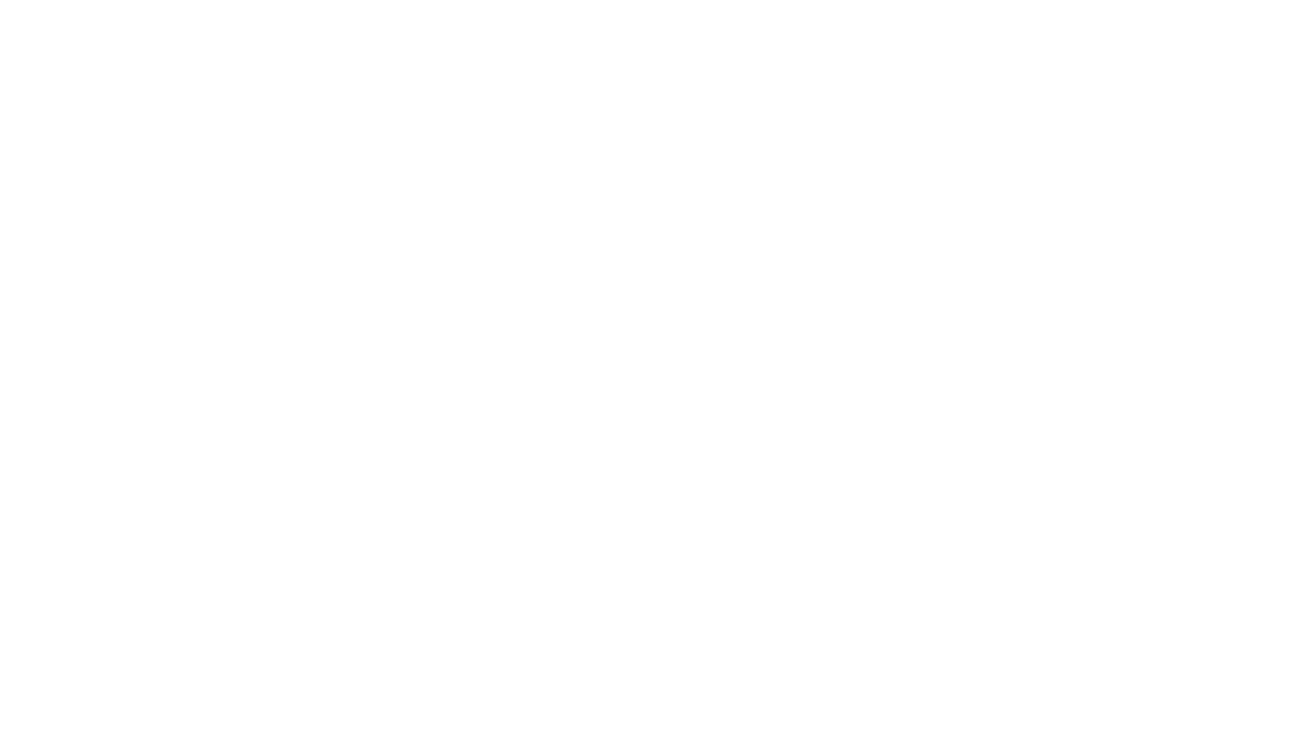
FIGUREA1 | Simplified scheme of the five-compartmental simulation model. (A) The continuous distributions are depicted by line plots for each of the 5 compartments represented by 3 individual marker distributions.To aid visualization the distributions are scaled to half-maximum (blue-colored compartment) or maximum (all other) observed values. (B) The bar plots show the mean–averaged fraction abundances including SD among